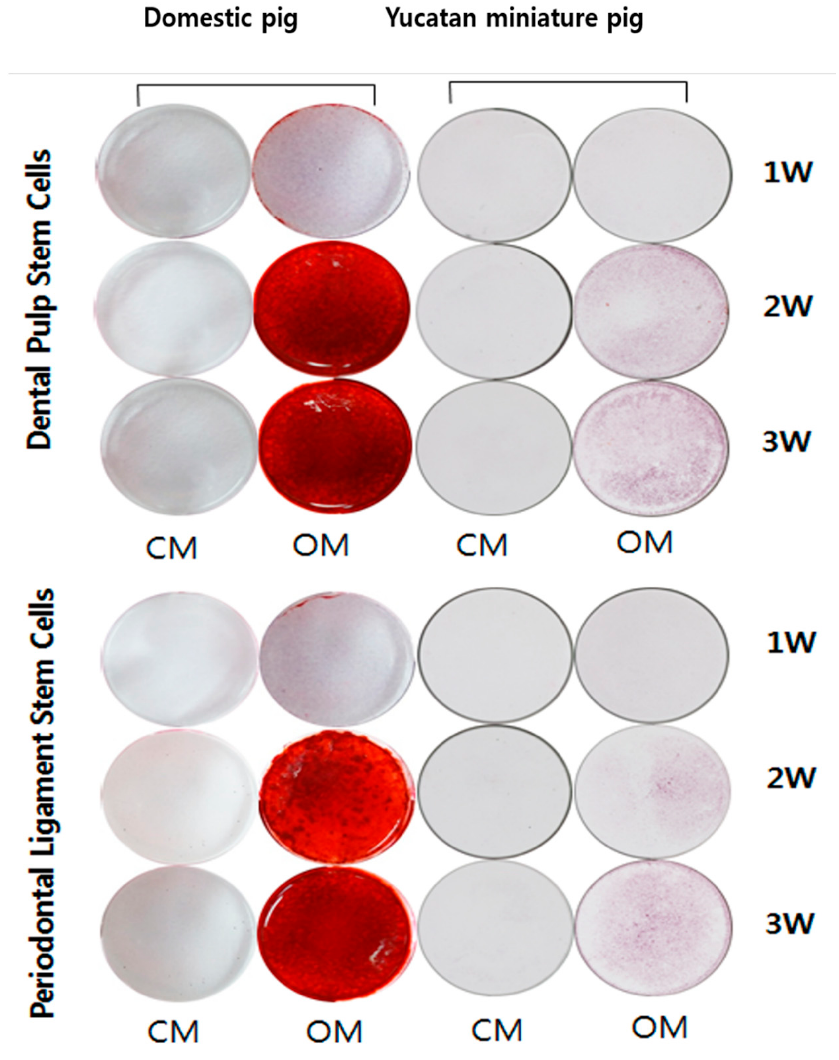
Figure 5. Alizarin red S staining of the dental pulp stem cells (DPSCs) and periodontal ligament stem cells (PDLSCs) of the miniature pig breed and the domestic farm pig breed, cultured in controlled media (CM) and osteogenic media (OM), after 7, 14, and 21 days of culturing. Mineralization was observed from 14 days of culturing in the DPSCs and PDLSCs of the domestic farm pig breed, whereas weak mineral depositions were observed in the DPSCs and PDLSCs of the miniature pig